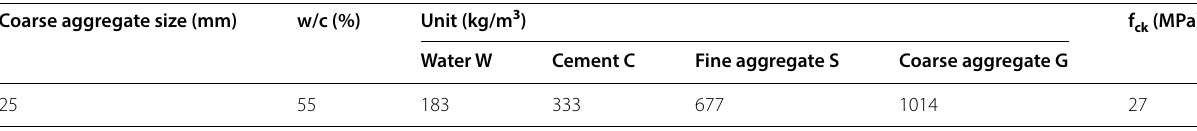
Table 1 Mix proportion of concrete (Kim et al. 2015). Coarse aggregate size (mm)